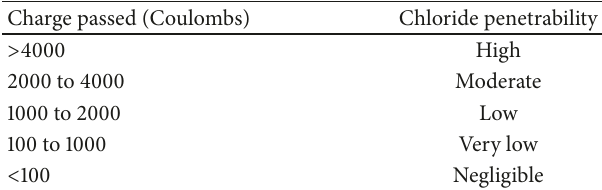
Table 5: Chloride penetrability.